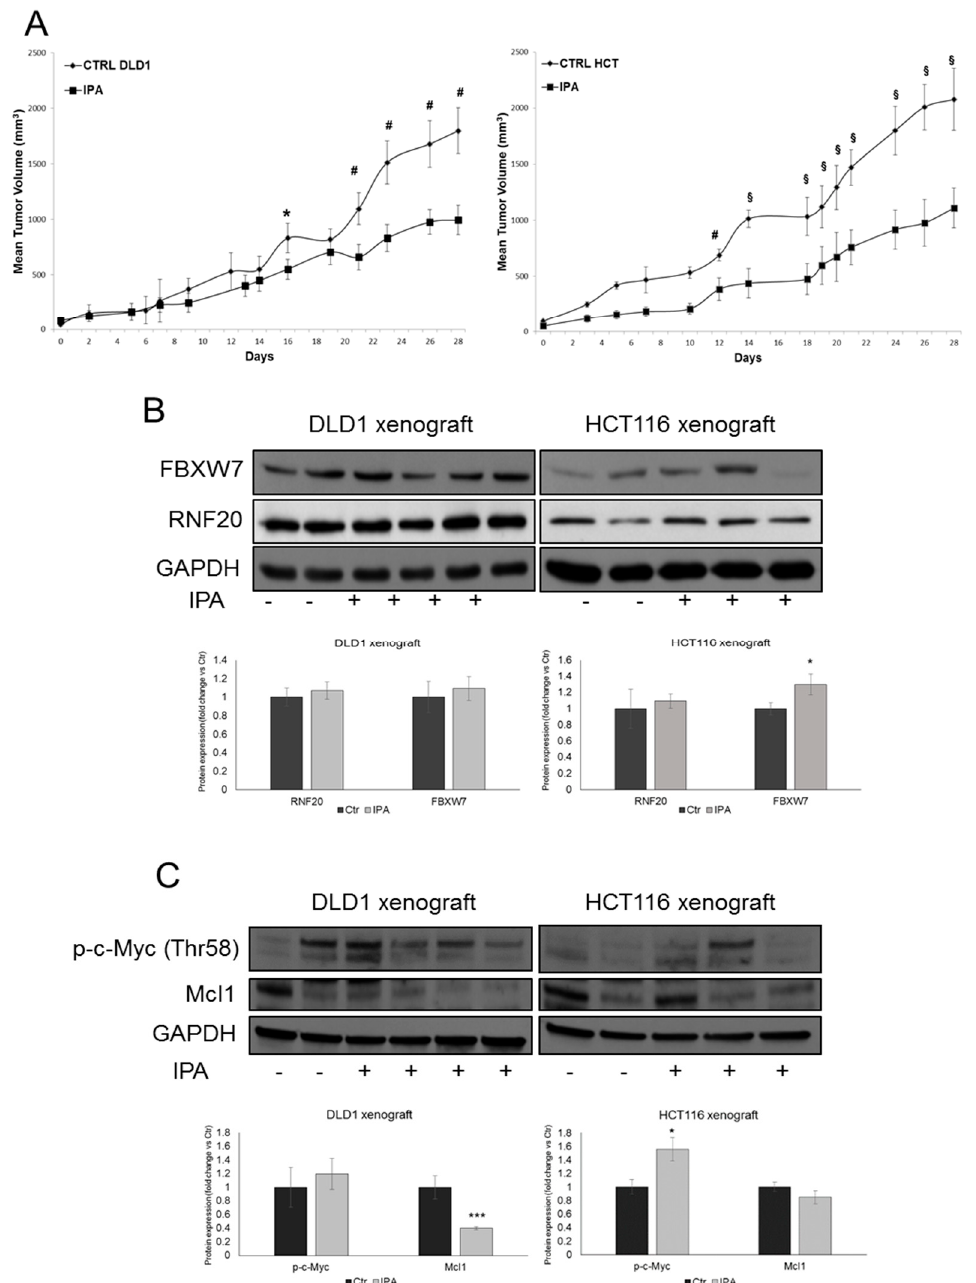
Figure 6. IPA reduces CRC growth in vivo. ( A ) Tumor volume growth curve of DLD1-xenograft (left panel, n = 20 mice, 10 mice in each group) and HCT116-xenograft (right panel; n = 20 mice, 10 mice in each group) after peri-tumoral injection of IPA. Growth retardation by the compound was statistically significant for all time points labelled with * (one-way ANOVA p < 0.05), with # (one-way ANOVA p < 0.01) and § (one-way ANOVA p < 0.001). Western blot and densitometry analysis of FBXW7, RNF20 ( B ), phosphorylated-c-Myc (Thr58) and Mcl1 ( C ) in whole lysate from representative resected tumor tissues. GAPDH was used as loading control. Data are expressed as mean ± SD of at least four independent experiments. * p < 0.05, *** p < 0.005 vs. control group.